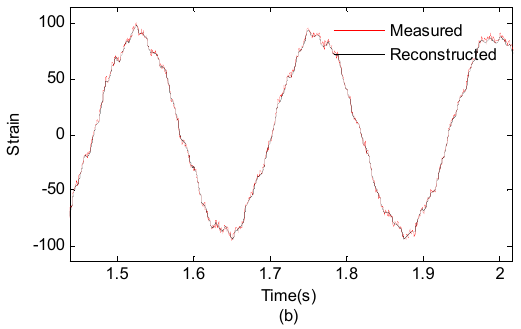
Figure 20. ( a ) Measured strain responses and reconstructed strain responses of the 1st optical fiber measurement data; (0~4 s) ( b ) Results are concentrated on 1.5~2 s for clear presentation.